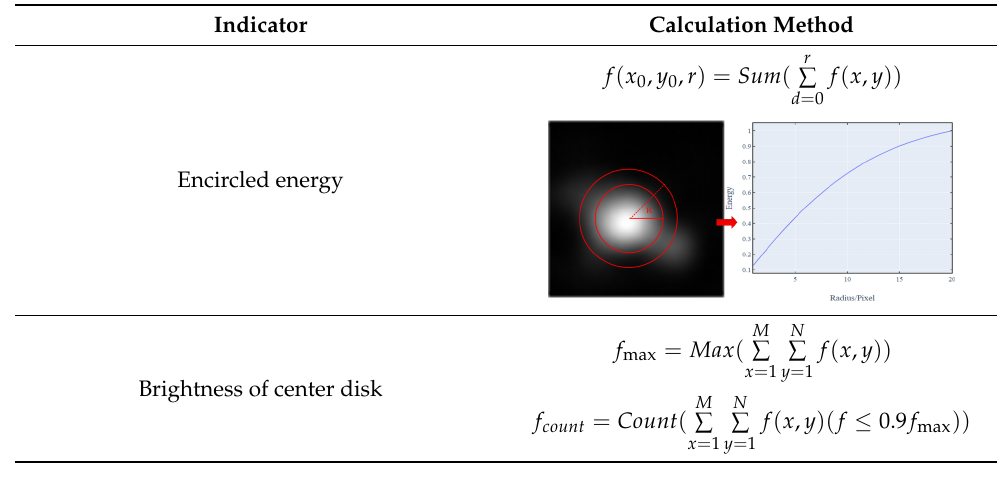
Figure 4. Calculation flow of the optical transfer function for laser emissions state evaluation. ( a ) Transmitted waveform of laser. ( b ) Fourier transform process. ( d ) Laser spot and its rendered im- age. ( e ) Laser emission state curve. ( c ) and (f ) respectively correspond to Fourier change results of emission waveform and laser emission state curve.